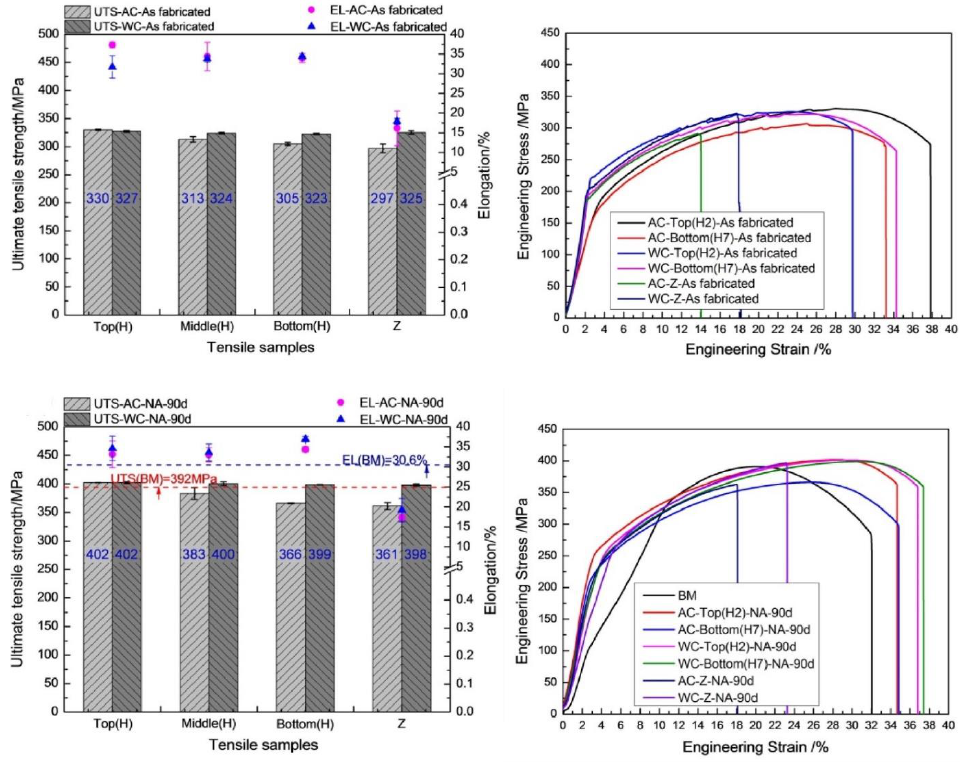
Figure 14. Tensile strength comparison of air-cooled and water-cooled identical material builds (at the top and bottom), as well as natural aging application on as-fabricated laminates (reprinted from [85] with permission from Elsevier).